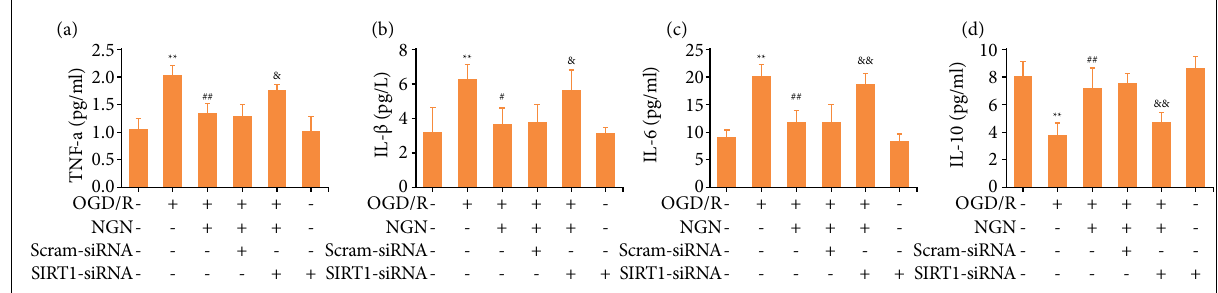
Figure 6 – Effects of SIRT1-siRNA transfection on the inhibition of naringenin on inflammatory response in OGD/R-treated HT22 cells. After transfection with SIRT1-siRNA (50 nmol·L –1 ) or scramble siRNA (50 nmol·L –1 ) for 6 h, HT22 cells were treated with naringenin (80 μ mol·L –1 ) for 2 h followed by treatment with OGD (6 h)/R (24 h). The levels of inflammation-related factors including (a) TNF- α , (b) IL-l β , (c) IL-6 and (d) IL-10 were measured by enzyme-linked immunosorbent assay (ELISA). Data were expressed as mean ± SD from three independent experiments. ** P < 0.01 vs. control group; # P < 0.05, ## P < 0.01 vs. OGD/R group; & P < 0.05, && P < 0.01 vs.